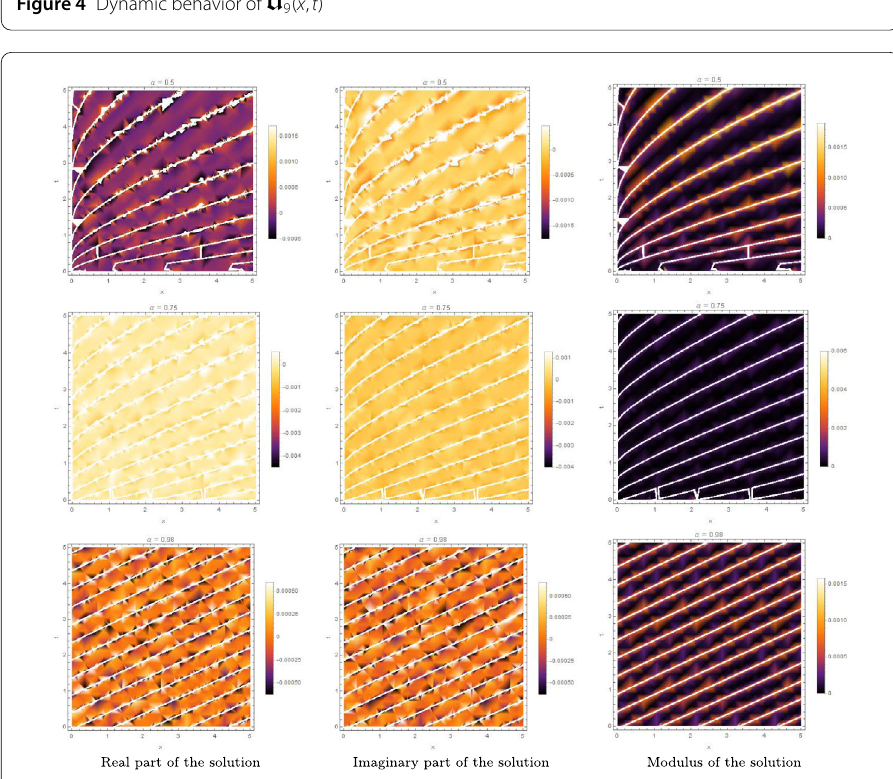
Figure 5 Dynamic behavior of U 10 ( x , t